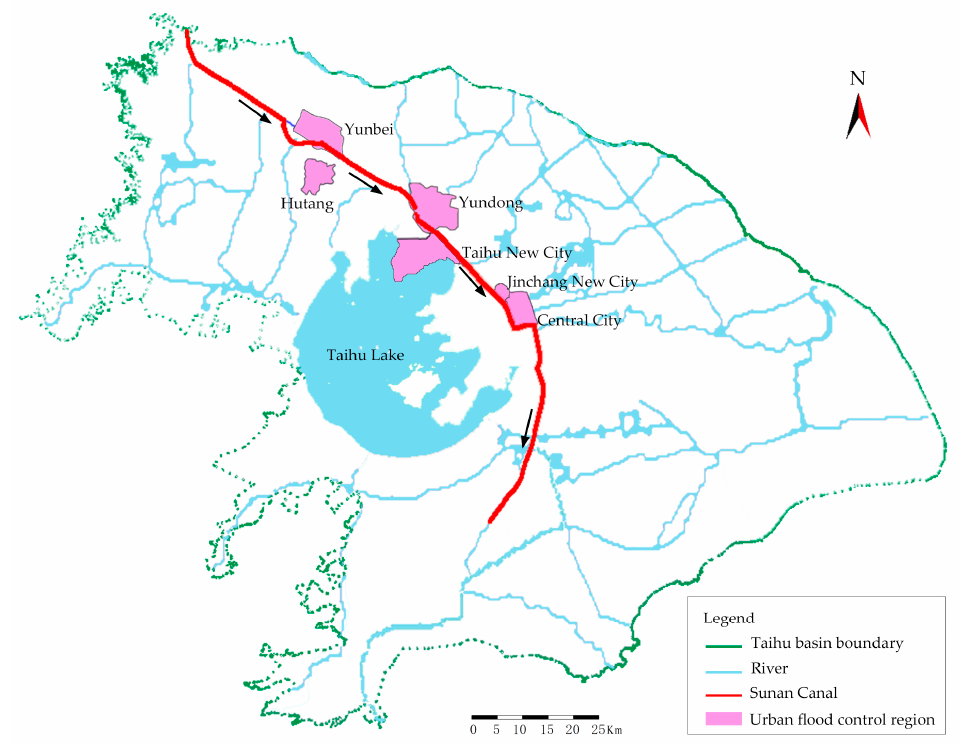
Figure 1. Sunan Canal and urban flood control regions.